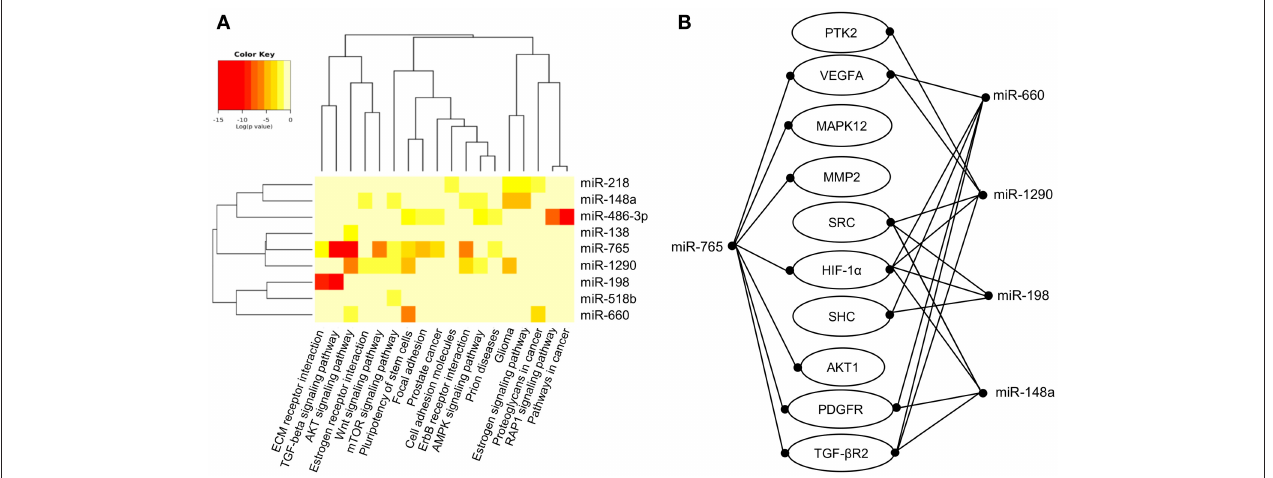
FIGURE 3 | Core miRNA/mRNA interaction networks. (A) . Supervised hierarchical clustering of signaling pathways affected by deregulated miRNAs. MicroT-CDS function and Euclidean correlation were used; a p < 0.05 was considered to identify significantly differentially expressed miRNAs in SKOV3 cells after 48h in hypoxia. Columns display the clustering of cellular pathways. Rows indicate the clustering of miRNAs names, and pathways are denoted at bottom. (B) Illustration depicts the modulated miRNAs after 48h of hypoxia and predicted target mRNAs involved in angiogenesis and vasculogenic mimicry.